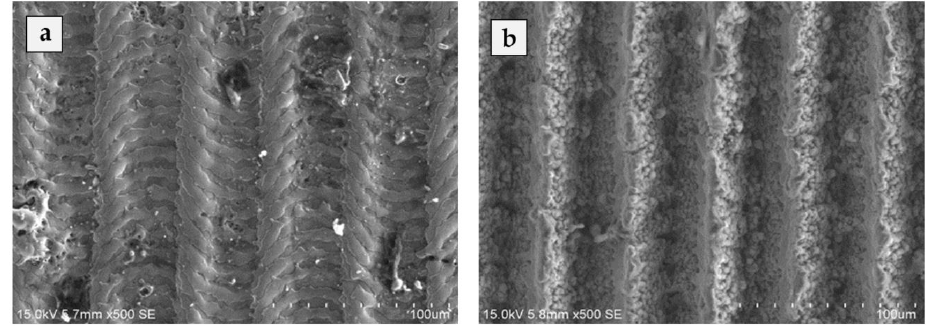
Figure 5. SEM imaging of laser-textured surfaces at 500× for: ( a ) 5 W and 250 mm/s; ( b ) 20 W and 10 mm/s.